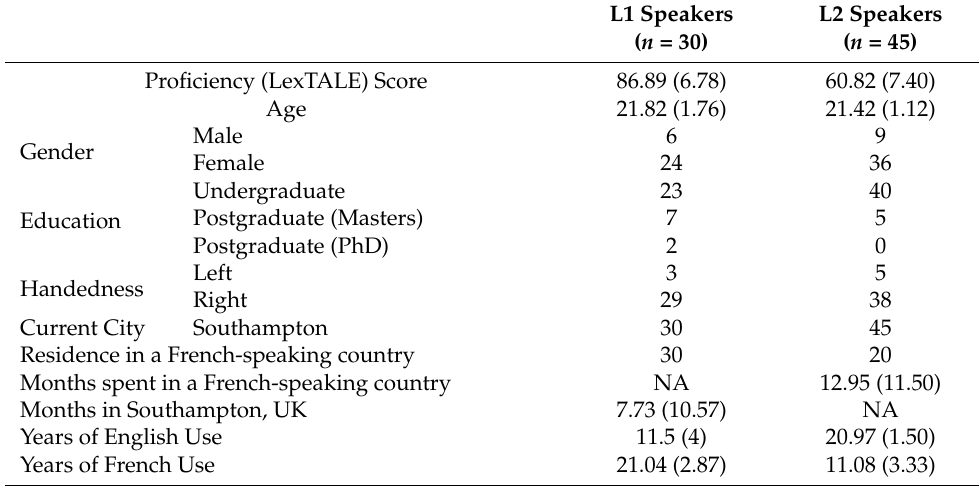
Table A2. Background information for participants. Means (standard